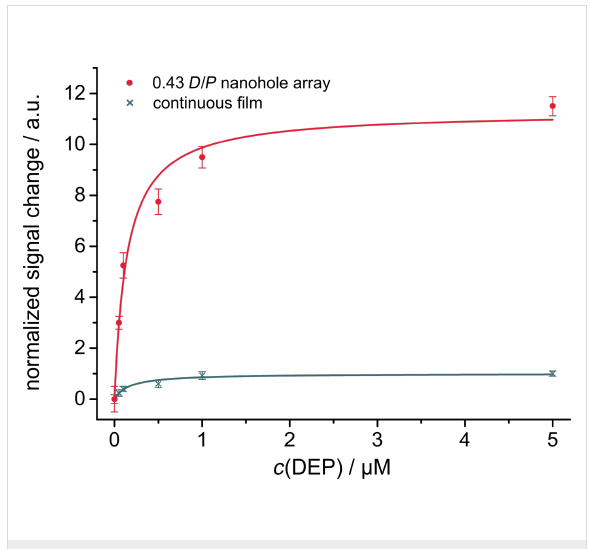
Figure 6: Normalized signal change at a constant angle in response to binding of DEP to rGO-modified nanohole arrays ( D / P = 0.43) covering a concentration range from 0.05 to 5 µM. For comparison the response of a continuous gold film modified with rGO is shown. Error bars indi- cate S/N. Data were fitted with the Langmuir equation (Equation